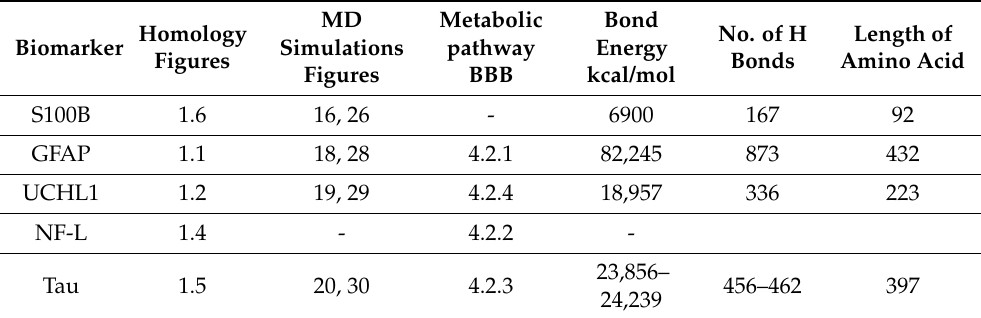
Table 7. Dynamic simulations of TBI biomarkers showing specific trends for possible use in TBI prediction